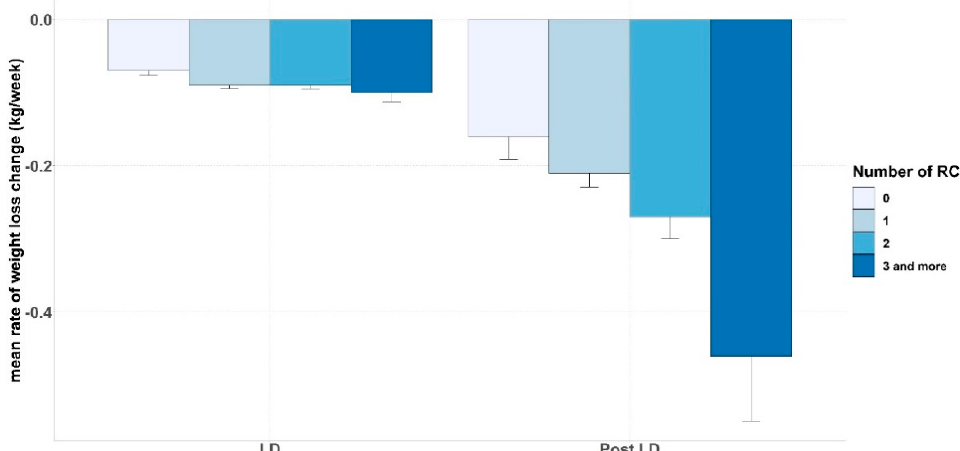
Figure 3. Rates of weight loss according to the number of remote consultation during and after the COVID19 lockdown periods. LD: lockdown; graph legend: number of remote consultation.